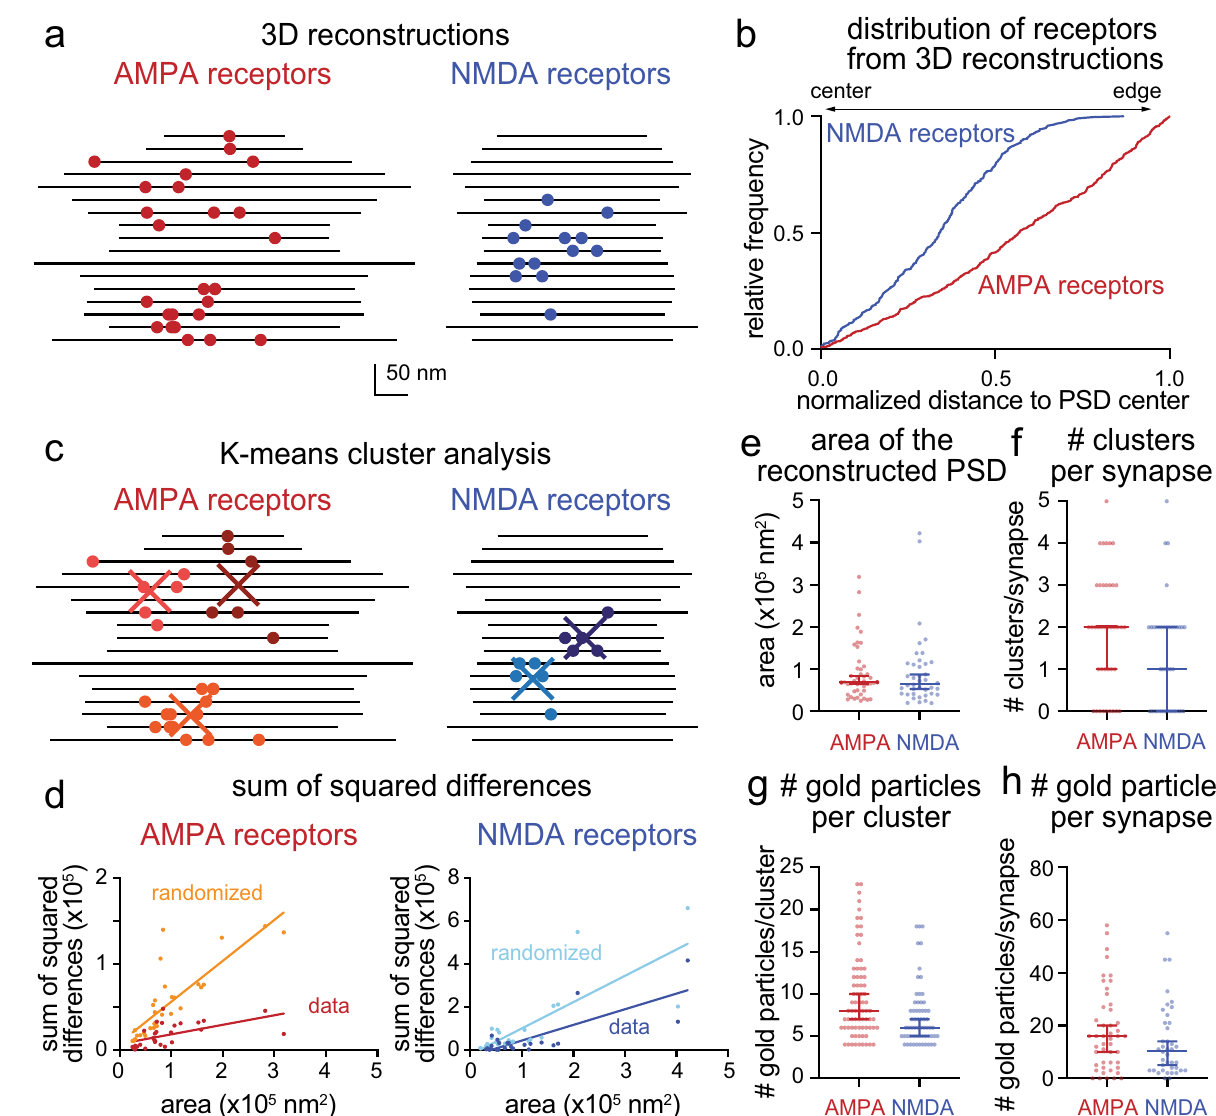
Fig. 2 AMPA and NMDA receptors cluster at the periphery and the center of the reconstructed postsynaptic density, respectively. a Examples of synapses from spin-mill serial block face scanning electron microscopy; each line indicates the extent of the cleft in a single 20-nm-thick 2D pro fi le, each circle indicates the location of a gold particle. b Cumulative relative frequency distribution of lateral distances from gold particles to the center of the postsynaptic density (PSD) from 3D pro fi les. Distances are normalized to the size of the PSD and corrected as fractional area assuming a circular PSD: a gold particle at 0 would be exactly at the center, at 1 exactly at the edge, and at 0.25 equidistant between center and edge. AMPA receptors are slightly biased toward the edge (median = 0.6, p < 0.001, n = 840 particles, N = 2 cultures), while NMDA receptors are biased toward the center (median = 0.3, p < 0.001, n = 550 particles, N = 2 cultures). c Same as a, except showing the centers of clusters determined by k-means clustering. d Sum of squared differences, calculated from each particle to the centroid of the cluster. Data: the actual distances of gold particles to their cluster center. Randomized: the distances of gold particles to their putative cluster center after randomizing the locations of gold particles at each synapse. Each dot: a synapse. Simple linear regression test: AMPA receptors, data, R 2 = 0.32, randomized = 0.67, p < 0.001; NMDA receptors, data, R 2 = 0.63, randomized = 0.62, p = 0.04. e Areas of the reconstructed postsynaptic densities. Each dot: a single reconstructed synapse. Error bars: median and 95% con fi dence interval, p > 0.6, Mann – Whitney test. f Number of clusters per synapse determined by k-means clustering. Each dot: a single reconstructed synapse. Error bars: median and 95% con fi dence interval, p = 0.06, Mann – Whitney test. Number of gold particles per cluster ( g ) and per synapse ( h ). Bias of particle locations toward the center or edge of the postsynaptic density in ( b ) was tested by comparing each group to a theoretical median of 0.5 using one-sample two-tailed Wilcoxon signed-rank tests. See Supplementary Data Table 1 for full pairwise comparisons and summary To test the spatial relationship between fusion events and Supplementary Fig. 3g, h) 4,50 . Of note, asynchronous fusion receptors, we measured the distance between receptors and intermediates at 11 ms were strongly biased toward the center docked vesicles or exocytic pits. The median distances from (Fig. 3a, b, d, median = 0.1, p < 0.001, and Supplementary docked vesicles to AMPA and NMDA receptors were 95 and Fig. 3a – d for more example micrographs). Thus, the distribution 73 nm, respectively, at rest (Fig. 3e, inset), and remained largely of fusion events during asynchronous release is similar to that of unchanged following stimulation (Fig. 3e, inset: AMPA receptors, NMDA receptors.